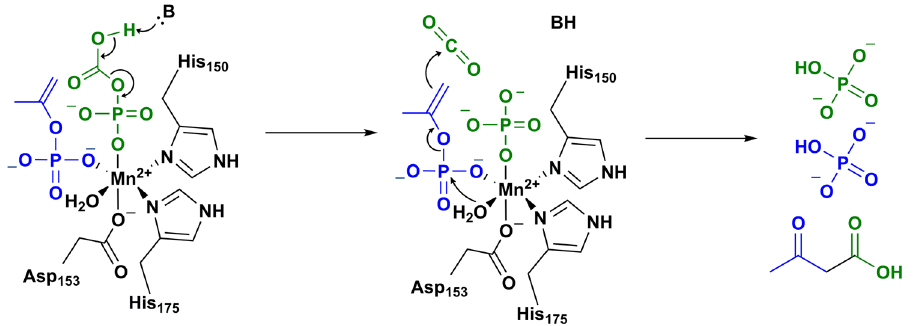
Figure 6. Reaction of intermediates to form products. A Mn active site mechanism of action is proposed. At the Mn active site, we propose a mechanism of action in two steps. It is reasonable to believe from our acetate- bound structure that the Mn is responsible for the ordering of the intermediates. ( A ) First, a residue near the carboxyl side of the carboxyphosphate will deprotonate the carboxylic acid which triggers a decarboxylation event to produce CO 2 and an inorganic phosphate. This initial reaction contains similarities to the PEPC Mn active site where a histidine residue stabilizes the carboxyphosphate intermediate, the AC-acetate bound structure shows His111 in proximity to the active site and can serve an analogous role. ( B ) After the decarboxylation event, the enol-acetone will then bond with the carbon dioxide after hydrolysis of its phosphate group. ( C ) The products of the reaction acetoacetate and two inorganic phosphates will then exit through the dimer interface restarting the Mn active